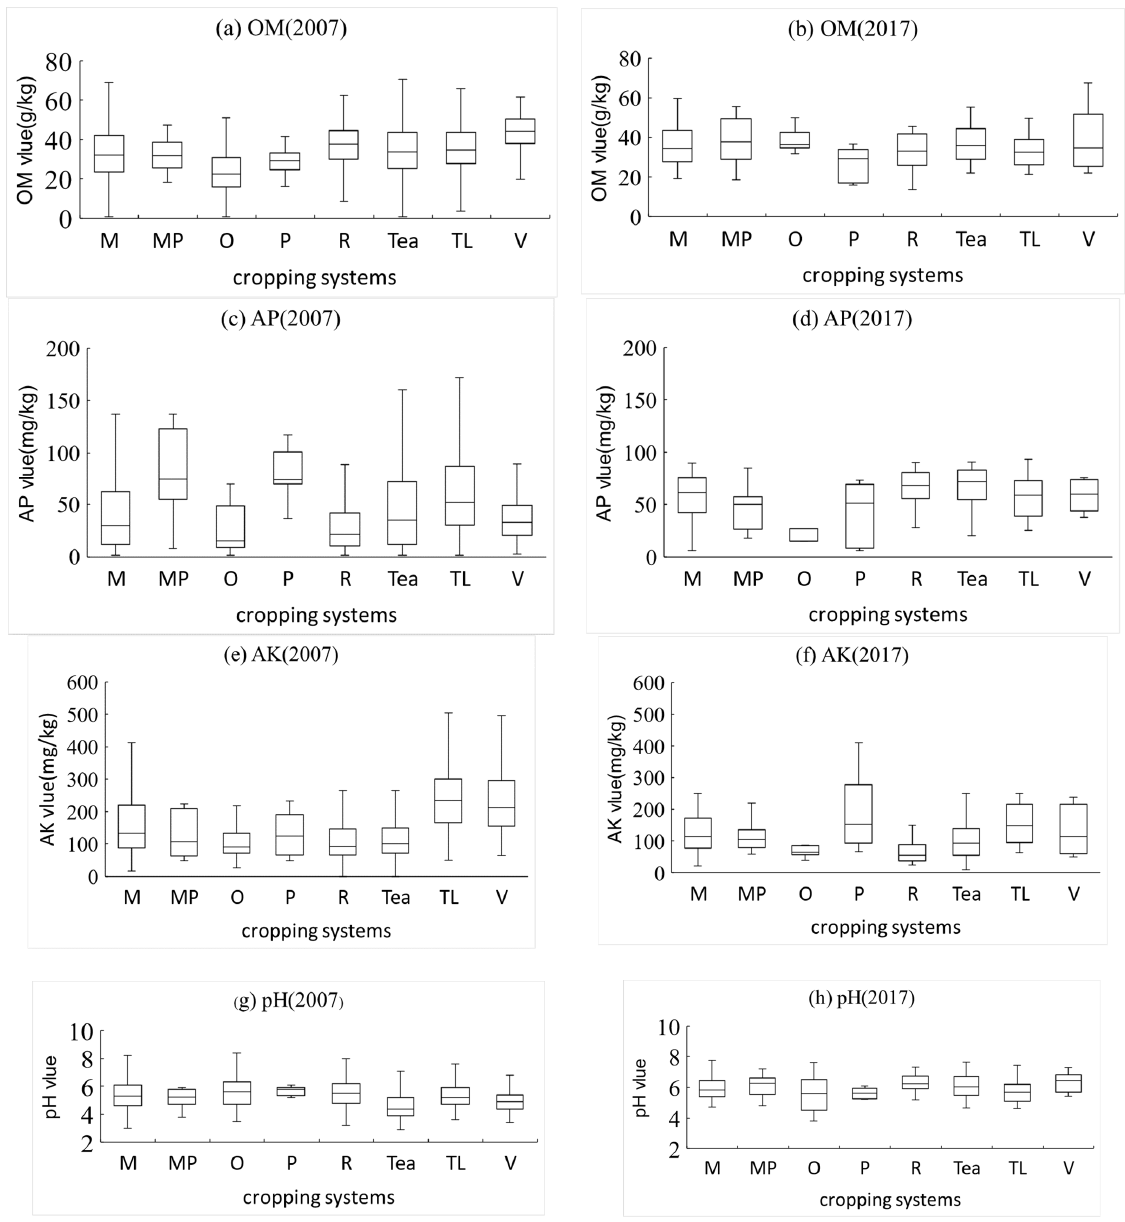
Figure 3. Box plots of contents of soil properties grouped according to cropping systems. (M—maize; MP—maize–potato; O—orange; P—potato; TL—tobacco leaf; V—vegetable). The box plots depict the minimum, maximum, median, and upper and lower quartiles of the data for each cropping system. ( a ) organic matter value2007(OM2007), ( b ) organic matter value2017(OM2017), ( c ) available phosphorus2007(AP2007), ( d ) available phosphorus2017(AP2017), ( e ) available potassium2007(AK2007), ( f ) available potassium2017(AK2017), ( g ) pH(2007), ( h ) pH(2017).